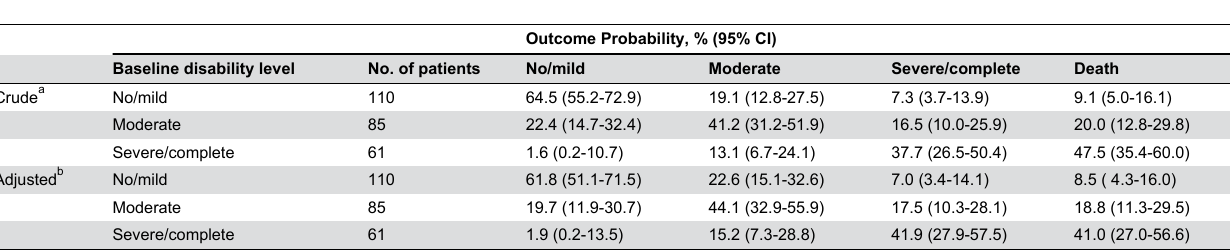
a. Correspond to overall values in Figure 4 b. Adjusted for age, sex and